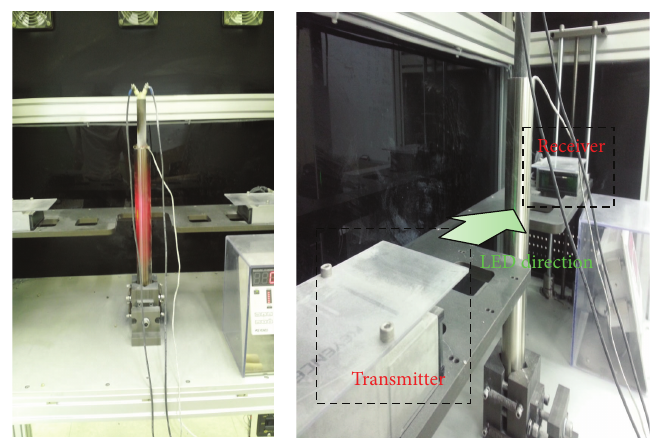
Figure 3: Measurement of thermal expansion.